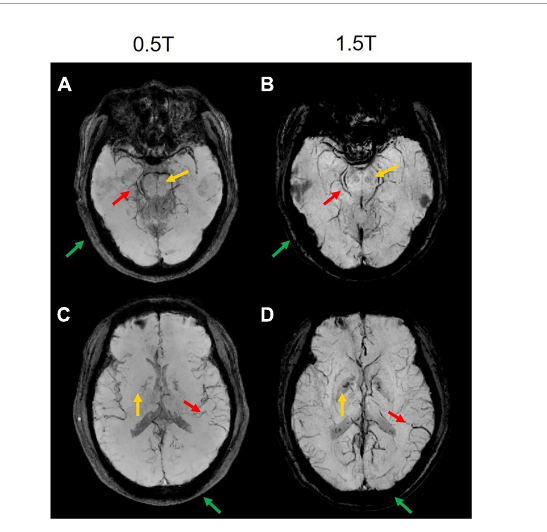
FIGURE6 The comparison results of two representative slices from the same subject MRI scanning at 0.5T and 1.5T. (A,C) The magnitude-weighted susceptibility weighted images at 0.5T. (B,D) The magnitude-weighted susceptibility weighted images at 1.5T. Some small vessels are marked in red arrows, the red nucleus is marked in yellow arrows, the skull and extracranial lipid are marked in green